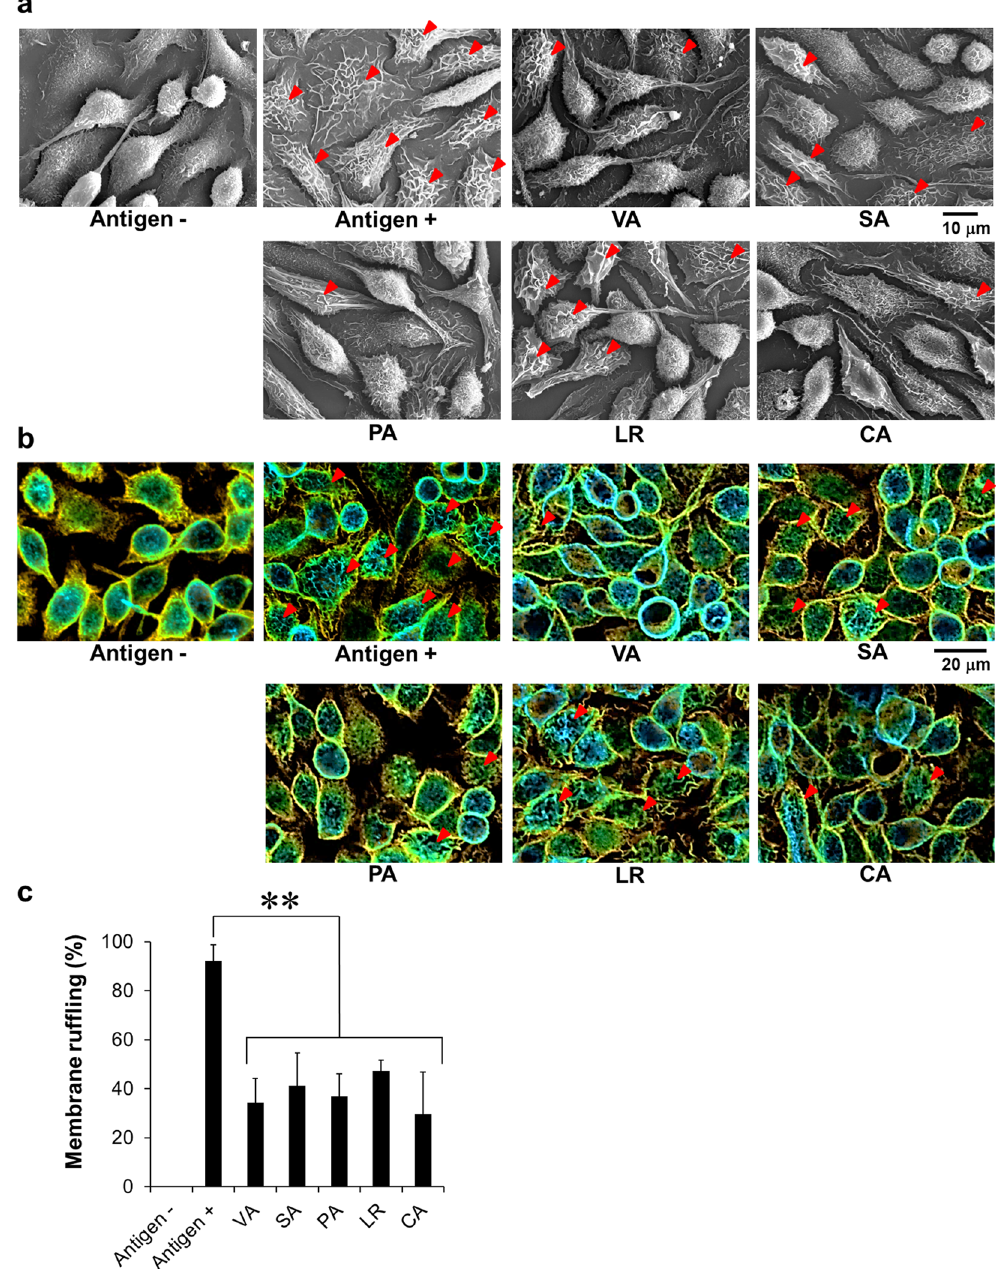
Figure 9. SEM and CLSM images of RBL-2H3 cells. IgE-sensitized RBL-2H3 cells were stimulated with DNP- BSA in the presence of active compounds derived from ume seed at 600 μ M or vehicle (0.1% DMSO). ( a ) Cells were fixed, dehydrated and lyophilized. Cells were then coated with palladium and platinum and visualized by SEM. ( b ) Cells were fixed and stained with Acti-stain 488 phalloidin. Cells were visualized by CLSM. Red arrows indicate cells with membrane ruffling. ( c ) The percentage of cells with membrane ruffling was calculated from 5–7 SEM images. ** p < 0.001, compared with antigen-stimulated